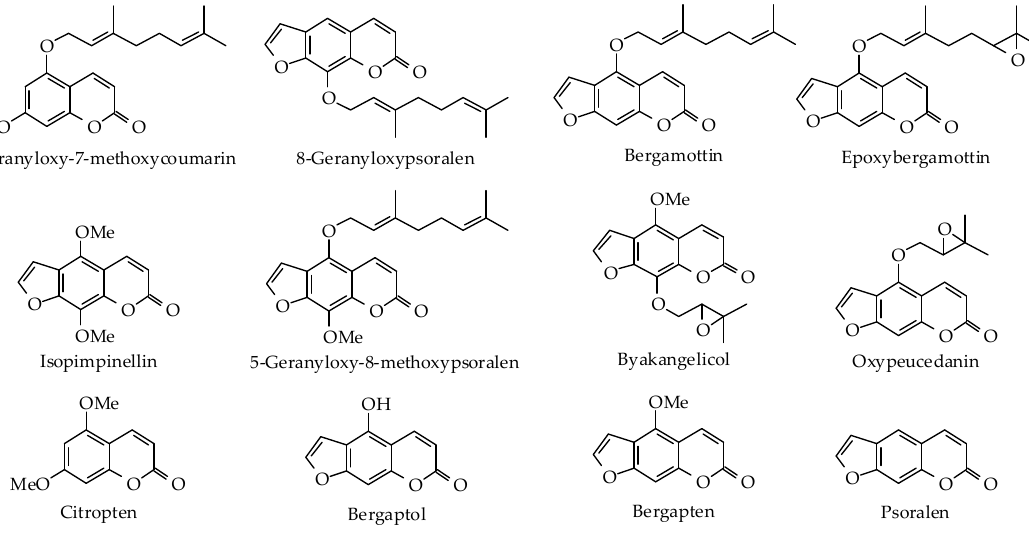
Figure 2. Chemical structures of key non-volatile components in expressed Citrus essential oils.